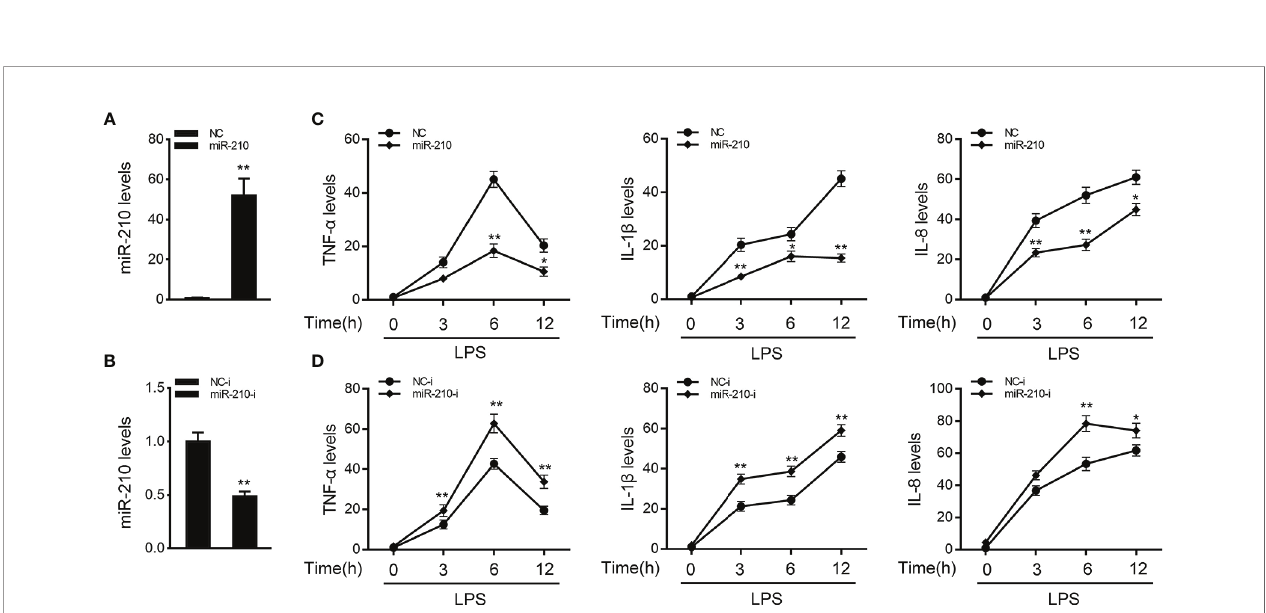
FIGURE 2 | miR-210 negatively regulate expression of in fl ammatory cytokines. (A, B) The miiuy croaker MIC cells were transfected with control mimics (NC) and miR-210 mimics (miR-210) (A) or miR-210 inhibitors (miR-210-i) (B) and control inhibitors (NC-i) within a fi nal concentration of 100 nM. After 48 h posttransfection, miR-210 expression was measured by qRT-PCR and normalized to 5.8S rRNA. (C, D) miR-210 or NC (C) and miR-210-i or NC-i (D) transfected into MIC cells for 48 h. MIC cells were then stimulated with LPS at different time points, then the mRNA expression levels of TNF- a , IL-1 b , and IL-8 were analyzed by qPCR and normalized to b -actin. Results are standardized to 1 in control cells. All data are presented as the means ± SE from three independent triplicate experiments. **p < 0.01; *p < 0.05 versus the